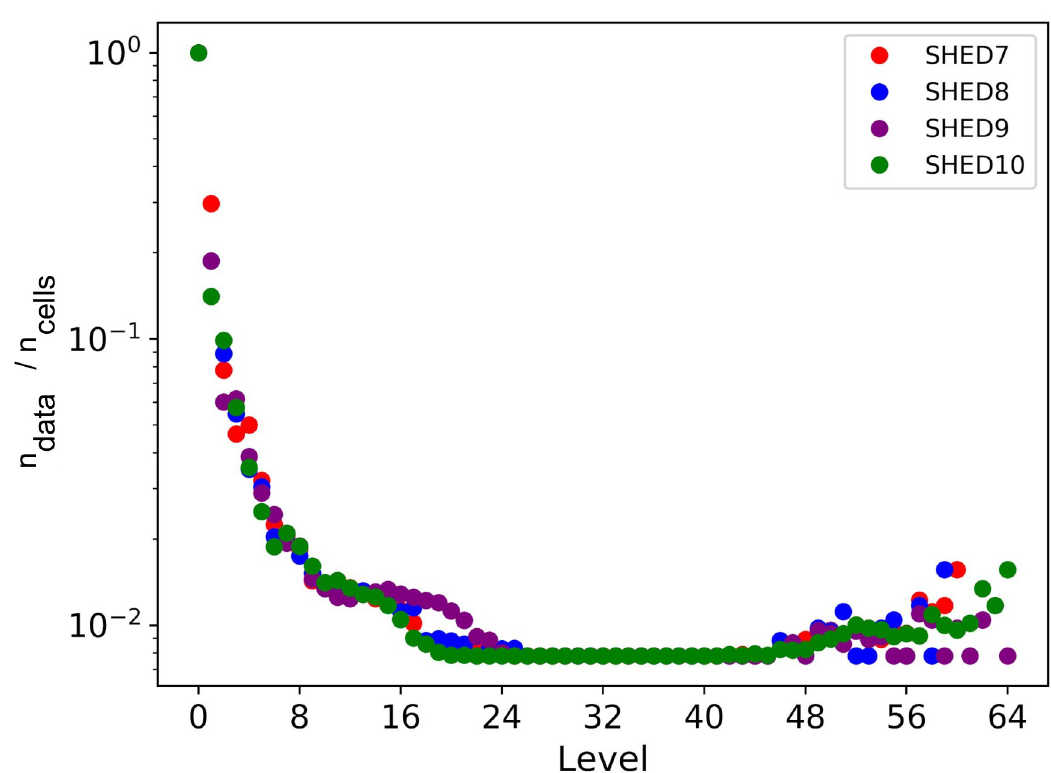
Fig 3. Proportion of nodes with data per